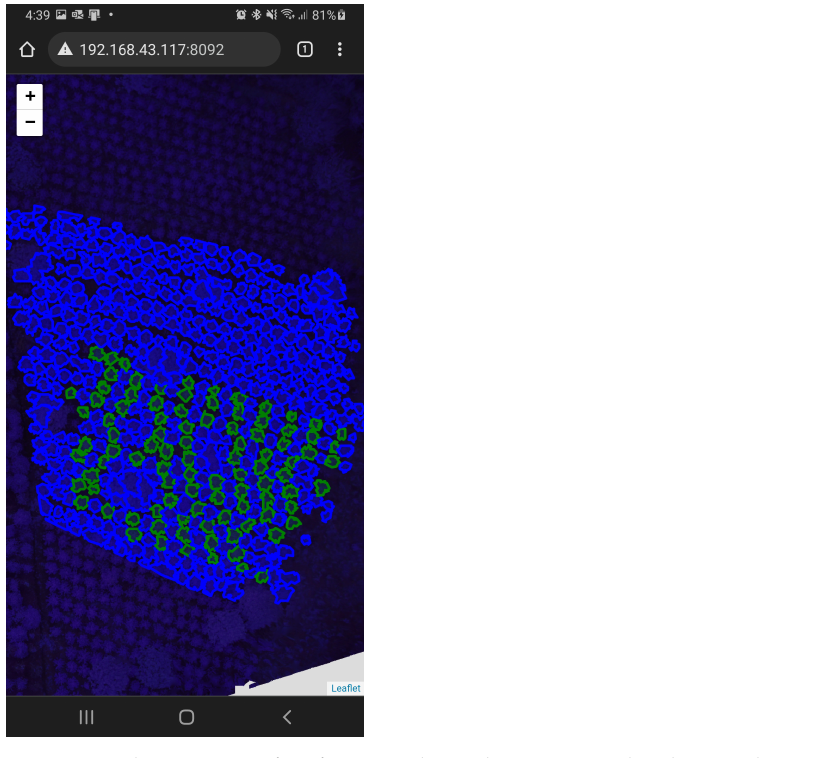
Figure 2. Web service interface for manual sampling, in green the plants with complete information, in blue the plants to be